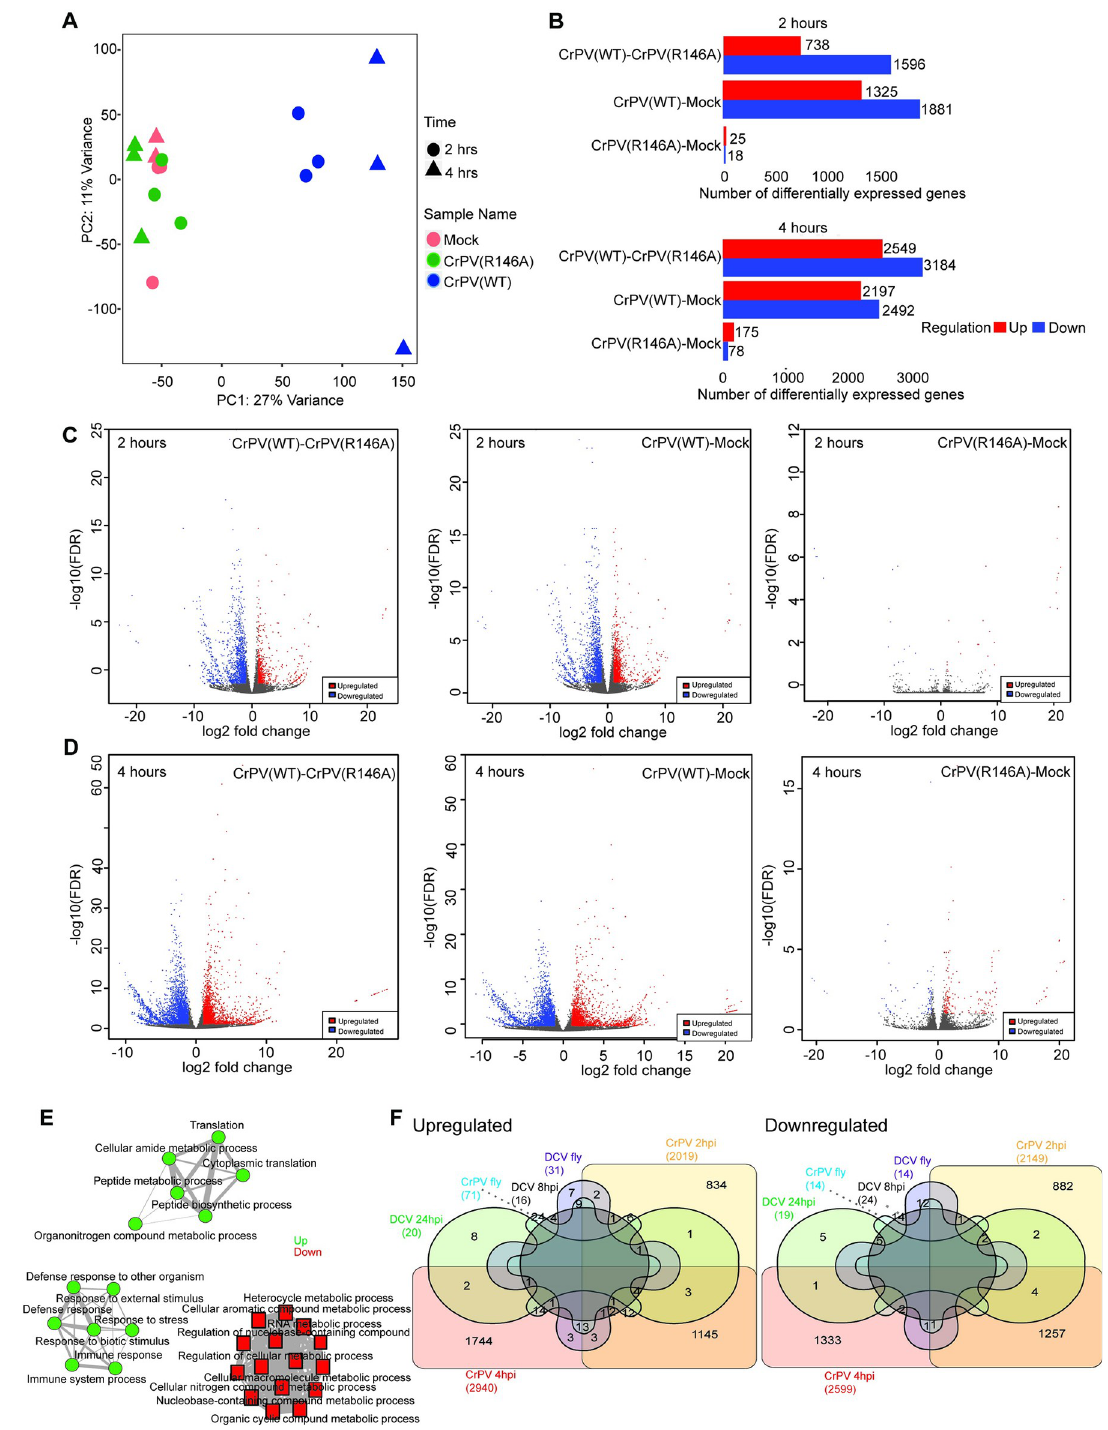
Fig 6. Transcriptional profiling of CrPV and CrPV(R146A) infected S2 cells. (A) Principal component analysis of transcriptional signatures from cells infected with Mock, CrPV or CrPV(R146A). (B) Bar graph indicating the number of differentially expressed genes for each comparison identified by DESeq2 (C) Volcano plots showing changes in gene expression with fold change (FC) in expression intensity of DEGs, plotted against corresponding FDR for 2 hrs and (D) 4 hrs. (E) Network analysis diagram showing Gene ontology analysis filtered by molecular function for CrPV infected cells (F) Venn diagram showing comparison of dicistrovirus transcriptome datasets [100].